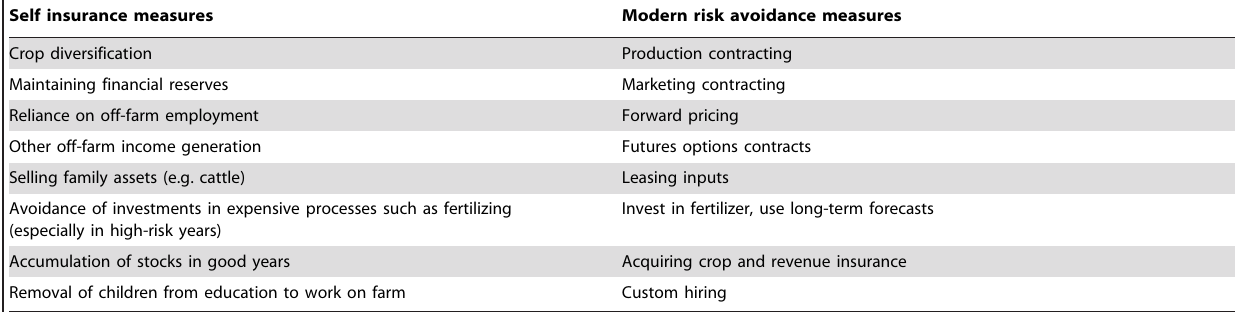
Table 1. Risk management